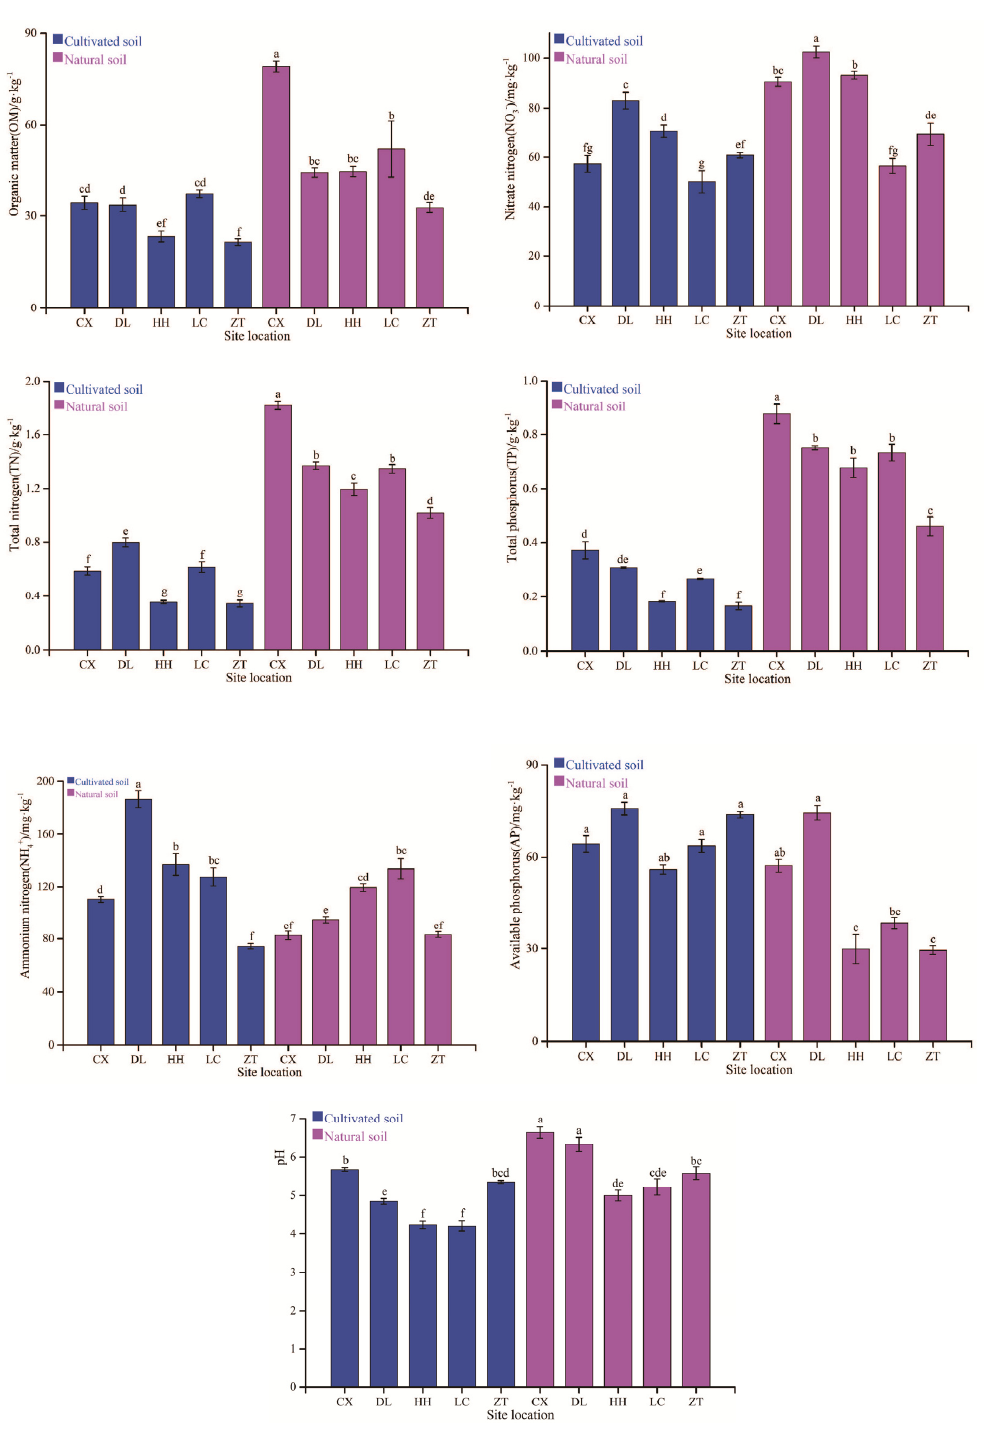
Figure 2. Soil chemical properties (mean ± SE, n = 3, error bars indicate the standard deviation) at naturally grown and cultivated walnut trees. Different lowercase letters on each column represent significant differences ( p < 0.05) between the natural and cultivated soil based on the least significant difference test. The blue bar chart shows the soil chemical properties of cultivated soil after fertilization, and the brown bar chart shows the soil chemical properties of natural soil in non-fertilization. CX, Chuxiong; DL, Dali; HH, Honghe; LC, Lincang; ZT,